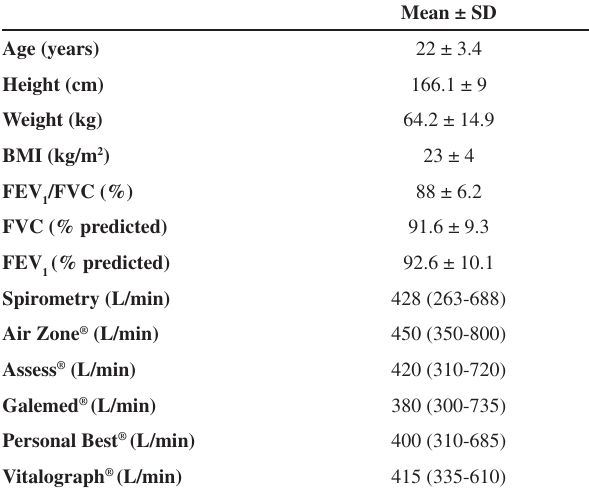
Table 1 - Mean and SD of the subjects’ age, height, weight, BMI, FEV /FVC ratio, FVC and FEV 1 rometric and the five meters PEF medians and interquartile ranges values.